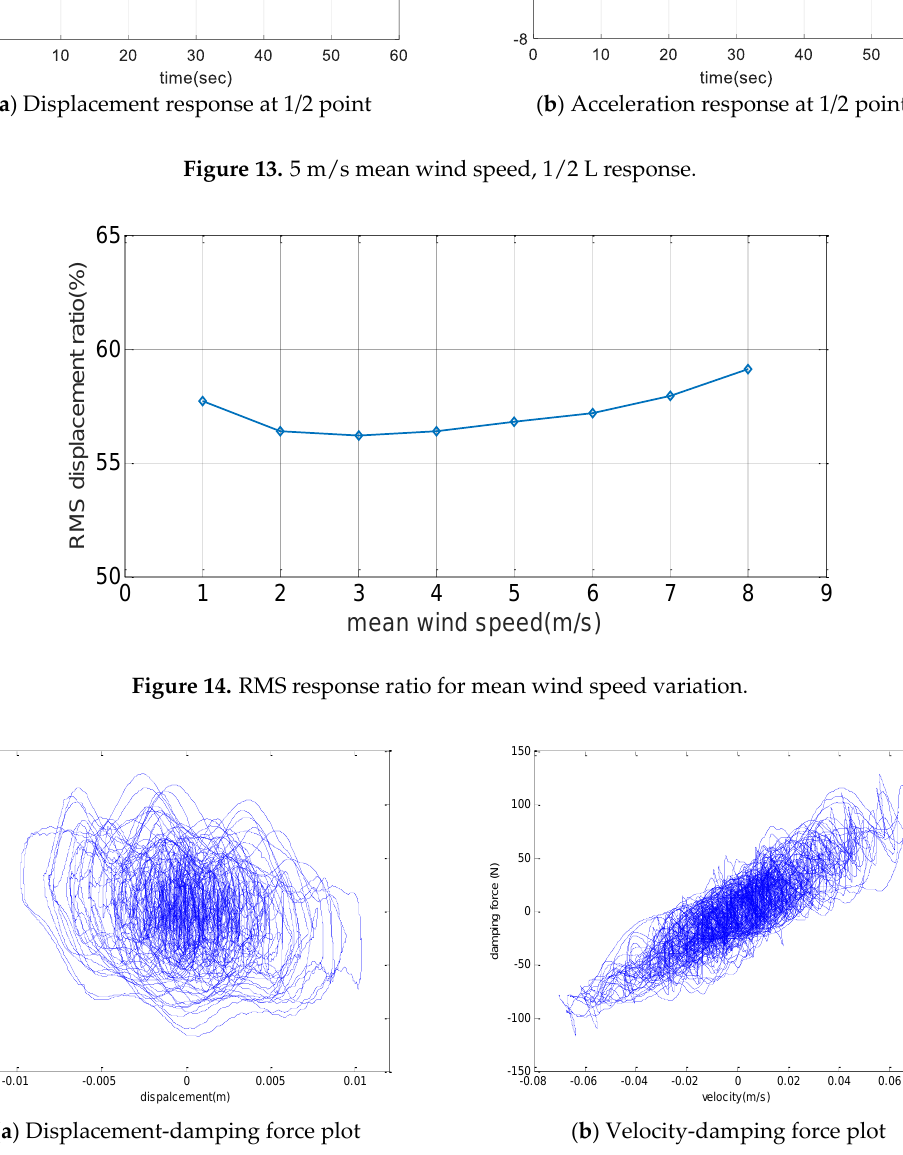
Figure 15. Hysteresis curve (mean wind speed of 5 m/s).